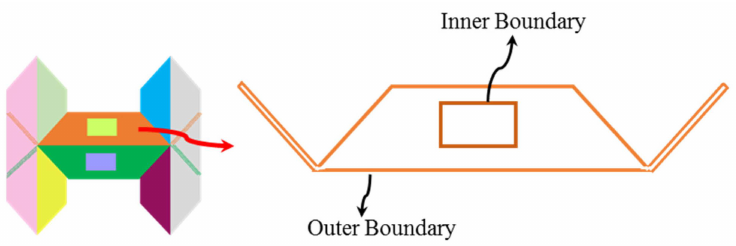
Figure 5. Inner and outer boundary derivation for the identification of intraclass competition for neighboring